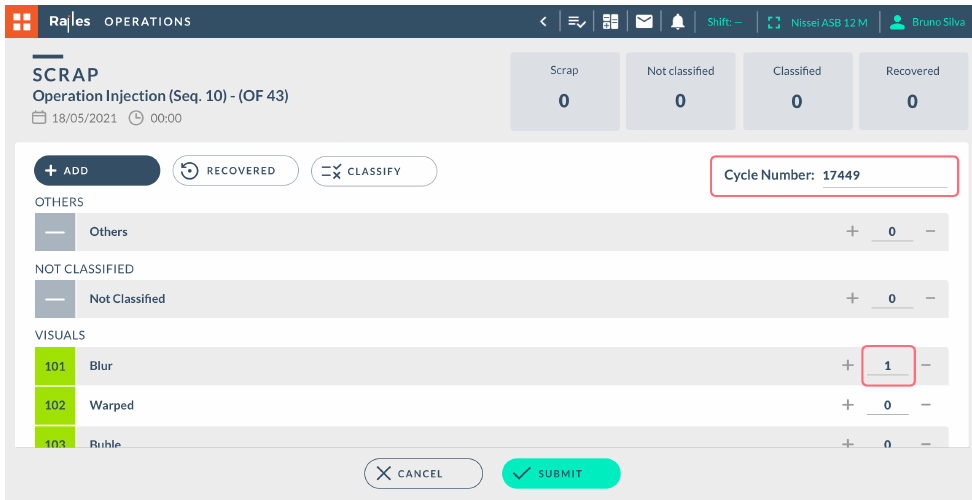
Figure 2. RAILES part classification by defect